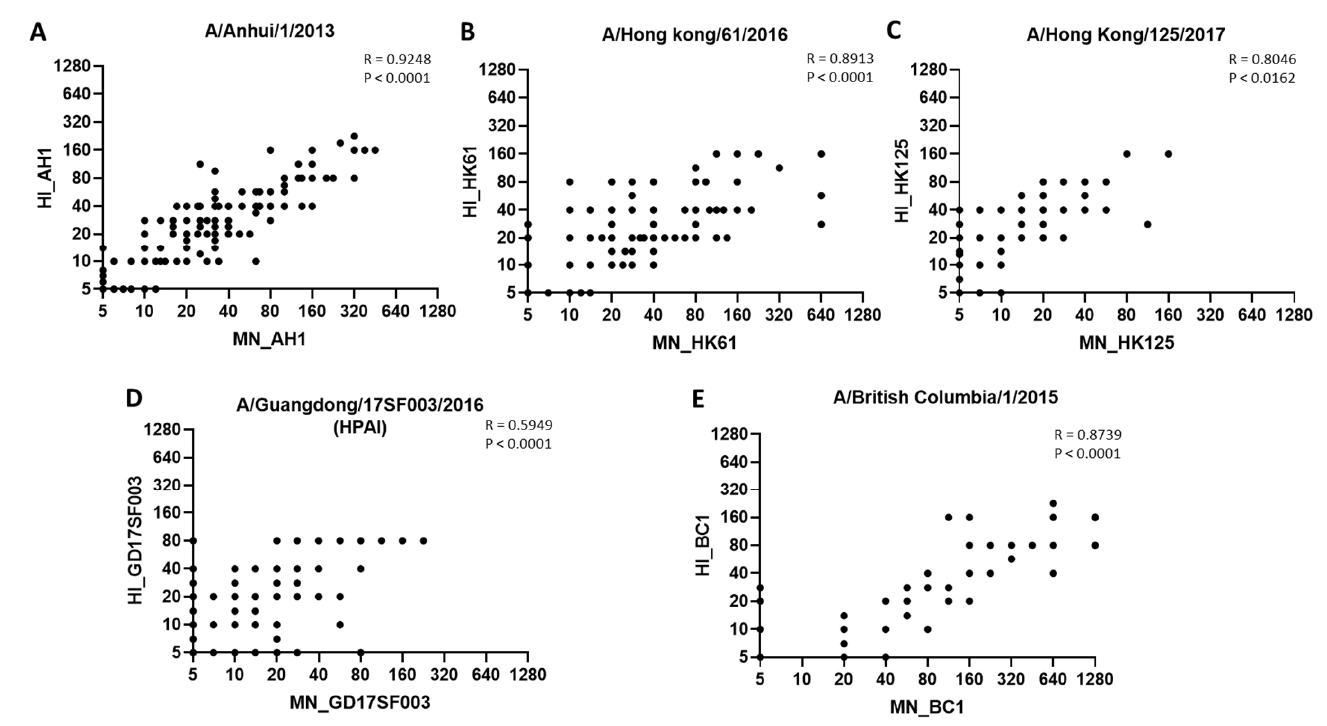
Figure 4. Correlation between HI and MN antibody titers to 1st, 3rd and 5th wave A(H7N9) viruses. Spearman correlation between HI and MN antibody titers to 5 A(H7N9) viruses. ( A ) A/Anhui/1/2013 (AH1); ( B ) A/Hong Kong/61/2016 (HK61); ( C ) A/Hong Kong/125/2017 (HK125); ( D ) A/Guangdong/17SF003/2016 (GD17SF003; ( E ) A/British Columbia/1/2015 (BC1). Dots represent titers to corresponding viruses. Table 2. Seroprevalence of HI and MN antibodies to A(H7N9) and A(H3N2) viruses in the US population (2010) across 9 age groups (6–102 years, N =